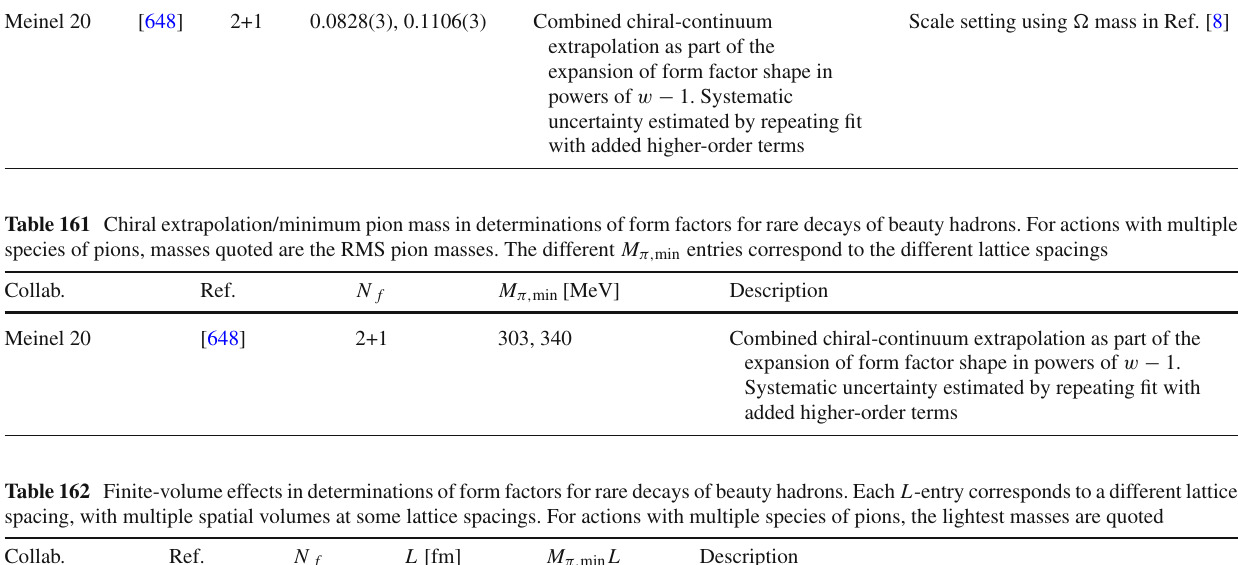
Table 160 Continuum extrapolations/estimation of lattice artifacts in determinations of form factors for rare decays of beauty hadrons Collab. Ref.